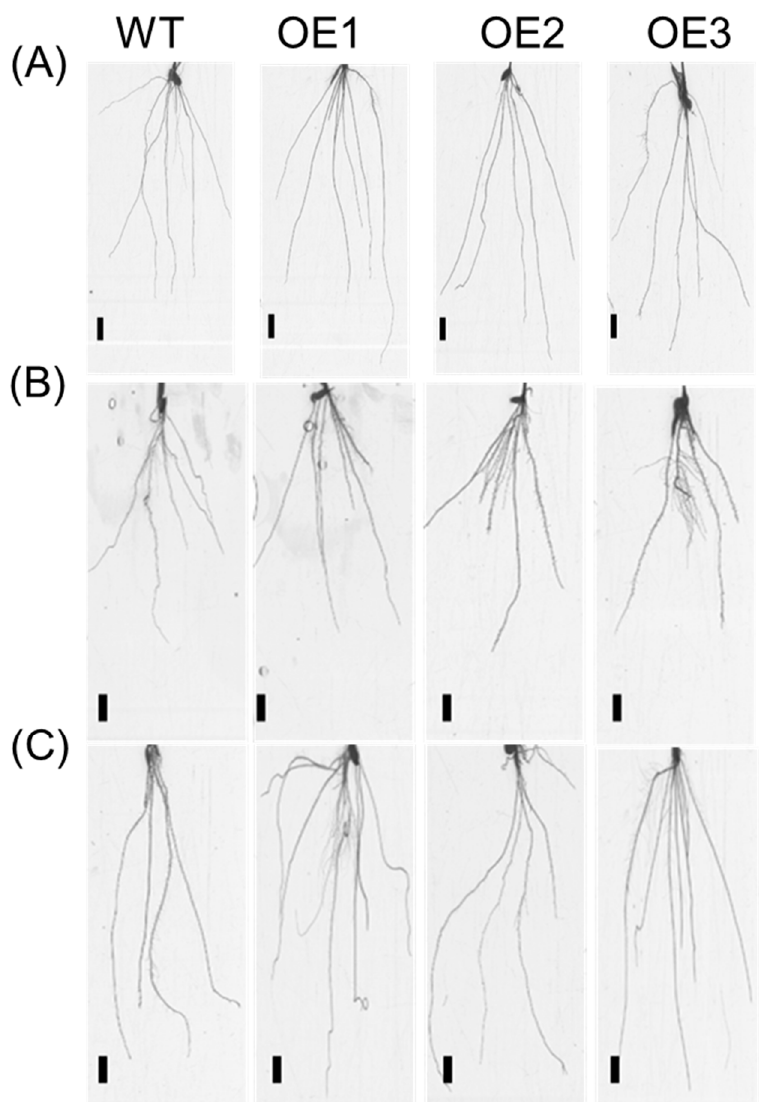
Figure 2. Root morphology of WT and OsNRT2.1 transgenic lines ( A ) under 0.25-mM NH 4 NO 3 conditions, ( B ) under 0.5-mM NH 4+ conditions, ( C ) under 0.5-mM NO 3 − conditions. WT and transgenic lines on the ninth day were shown in Figure 1 (bar = 1 cm).